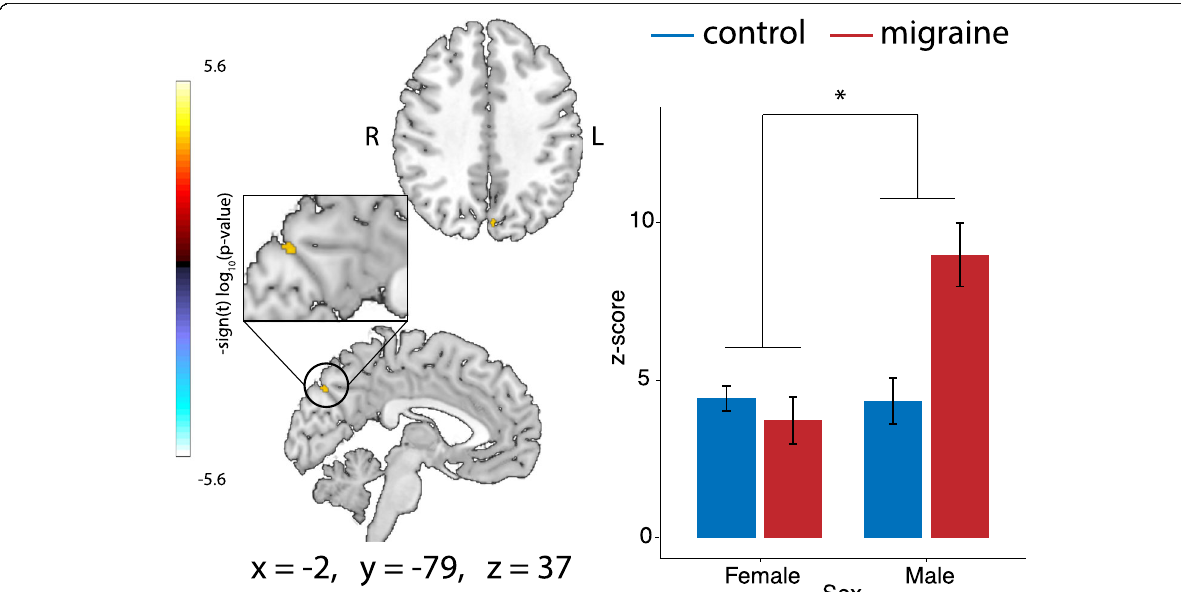
Fig. 3 Group by sex interaction effects on connectivity. Cluster in the precuneus exhibiting significant group by gender interaction effects of connectivity with the default mode network (number of voxels = 11) and connectivity values per group. * p <